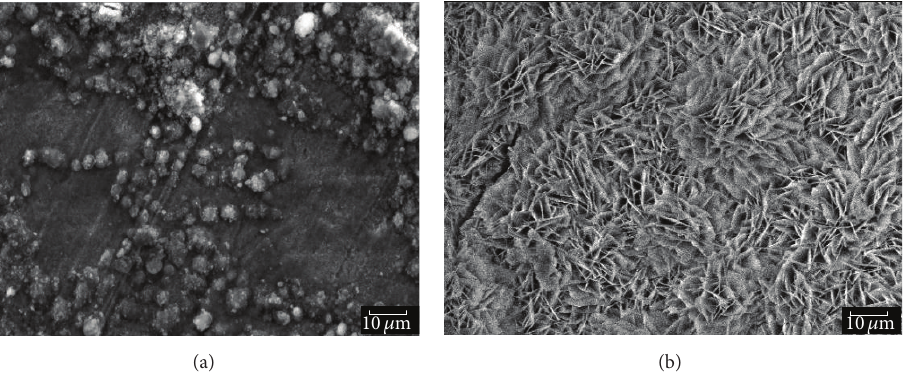
Figure 12: SEM images of galvanized steel immersed in CRS solution under different hydrostatic pressure at 293 K after 2 days, (a) 0.1MPa; (b)